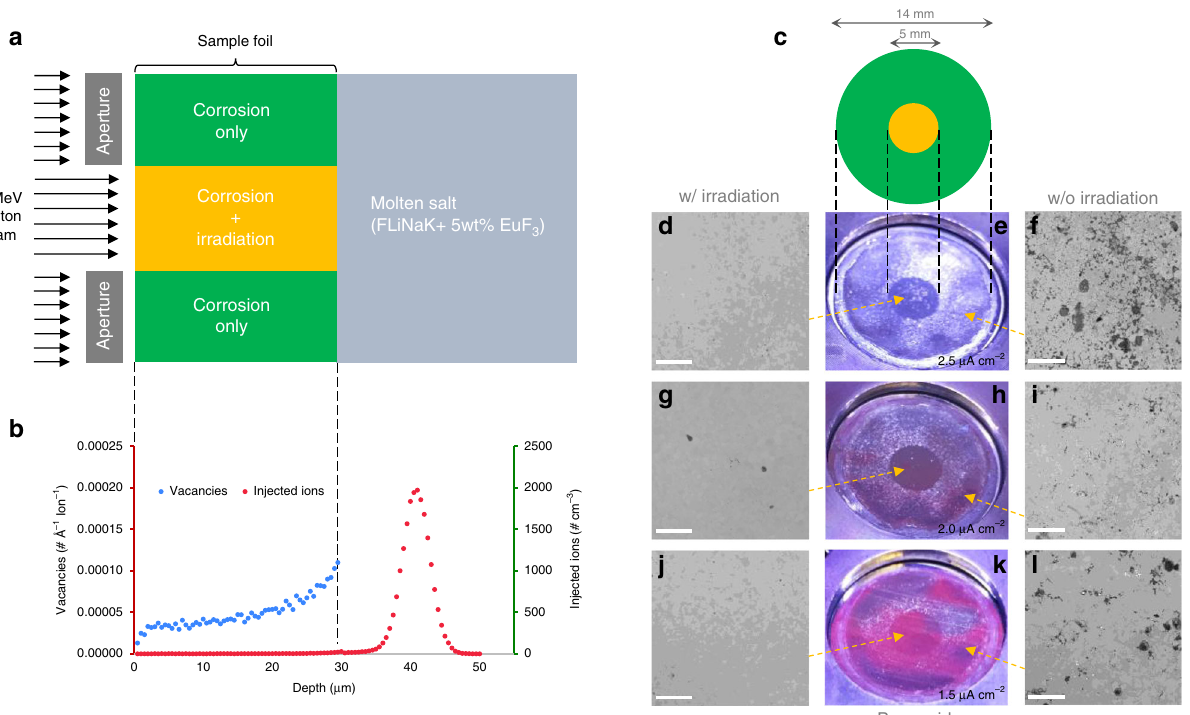
Fig. 1 Schematics of the experimental setup, sample con fi guration, and beam-facing side comparison regions of Ni-20Cr samples. a The experimental setup, showing how the two sample regions were created. b Distribution of primary radiation damage (blue dots) and proton deposition (red dots) along the irradiation direction for the Ni-20Cr corrosion experiments, simulated by SRIM 32 . c Schematic of the irradiated (in orange) and unirradiated (in green) zones. d – l Optical and representative SEM images of the beam-facing side of the Ni-20Cr foils after 4 h at 650 °C under various beam current densities. d – f , g – i , and j – l Correspond to beam current densities of 2.5, 2.0, and 1.5 μ A cm − 2 , respectively. Scale bar: 200 μ Fig. 4a, b. In our Ni – Cr binary alloy, Cr is preferentially depleted by molten salt because the redox potential of Cr is considerably lower than that of Ni in our LiF – NaF – KF + EuF 3 (FLiNaK + EuF 3 ) fl uoride salt 19 . Cr in the bulk would diffuse out of the system via